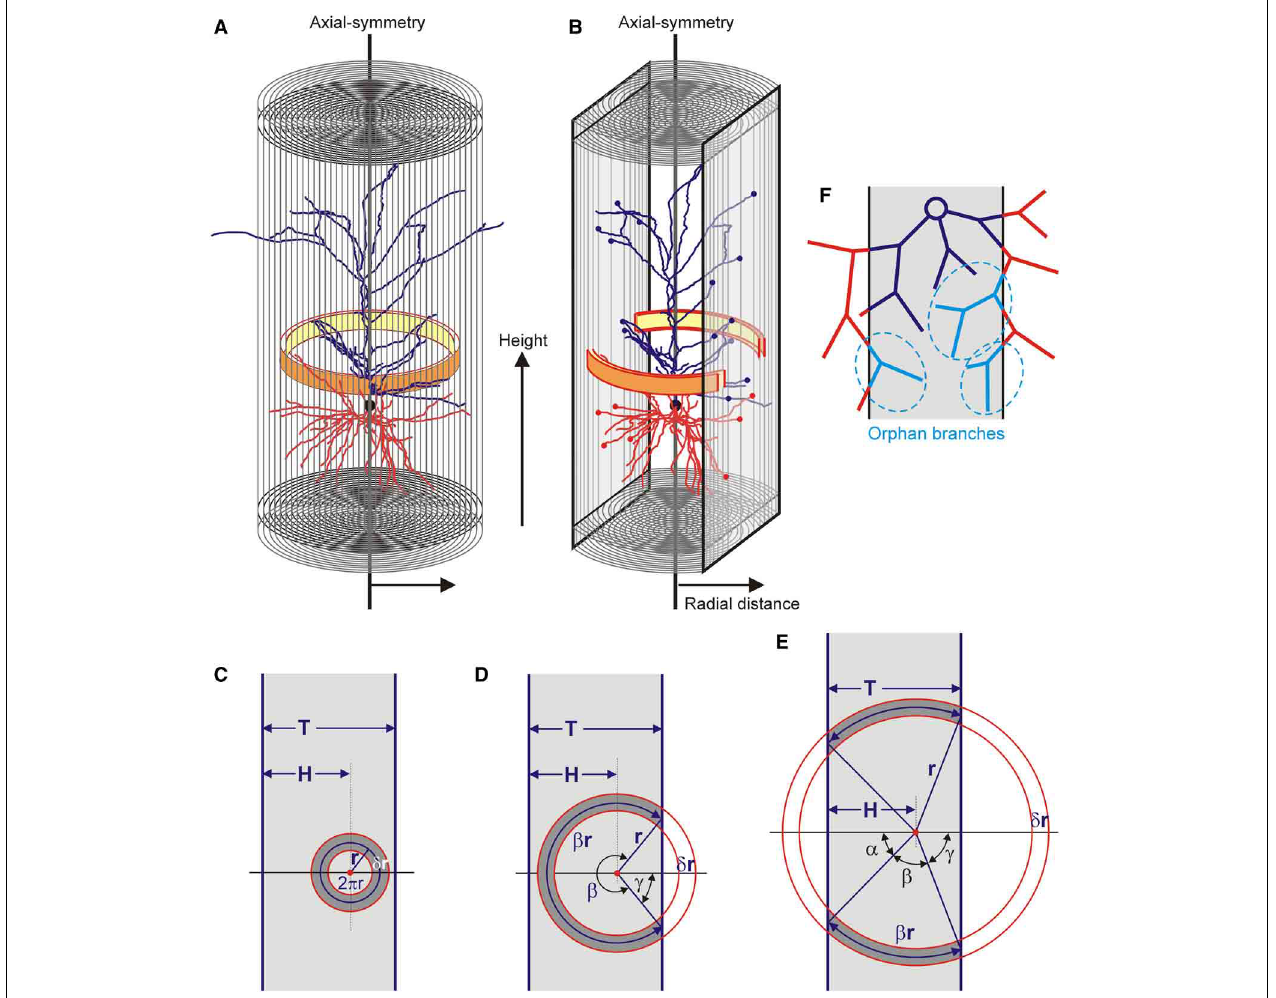
FIGURE 2 | (A) An axial radial coordinate system is used and axial symmetry is assumed. The distribution of mass is obtained by summing all the mass per integration ring (yellow-orange ring) at a given axial position (height) and with a given radius. The final distribution is given as a function of radius and height. (B) Within the restricted space of a slice, the integration ring becomes fractionated when it exceeds the slice boundary. (C–E) Three different conditions for the integration ring in a slice of thickness T . The integration ring has its center at a distance H from